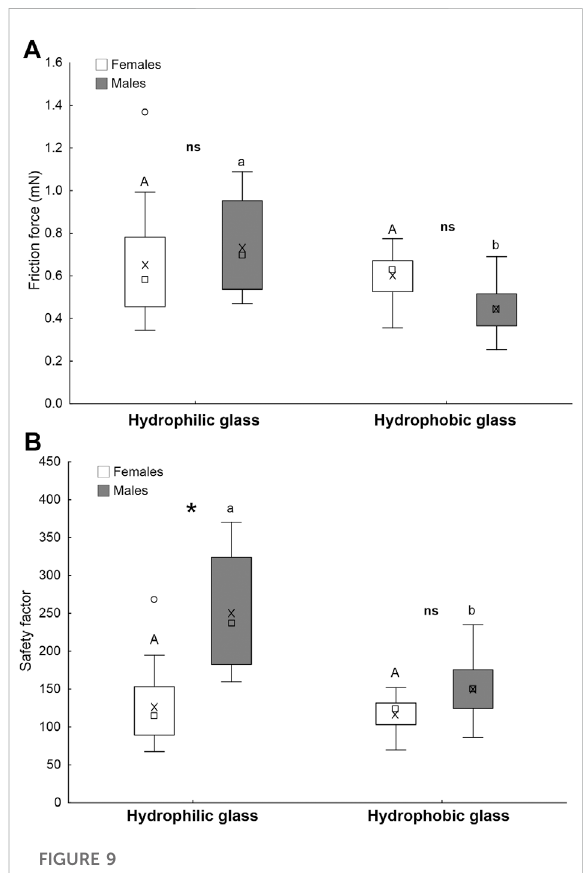
FIGURE 10 Pull-off force (A) andsafetyfactor(theforcedividedbyinsect weight) (B) of A. bifasciatus females and males on glass beads with different diameters (0.5, 1, 1.5, 2, and 3 mm) used as dummies of the host eggs. Boxplots show the interquartile range and the medians, whiskers indicate the 1.5 × interquartile range and “ ° ” shows outliers. Boxplots with different upper case letters and lower case letters, respectively, are signi fi cantly different at p < 0.05. In the comparison between females and males, the asterisk (*) means signi fi cant difference at p < 0.05 and ns means not signi fi cantly different (Tukey unequal N HSD post hoc test, Two- way